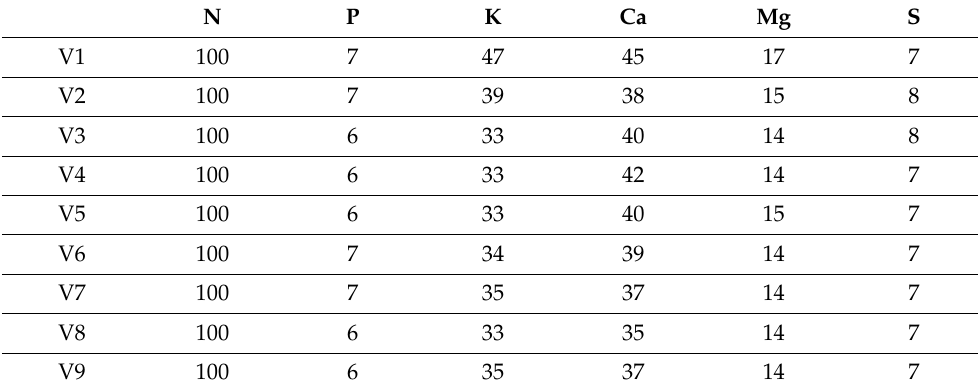
Figure 1. Average elemental contents in individual parts of the seedlings in relation to compaction of the substrate after growing the seedlings. Table 4. Percentage of macroelements in relation to N in the leaves from each substrate density variant after growing the